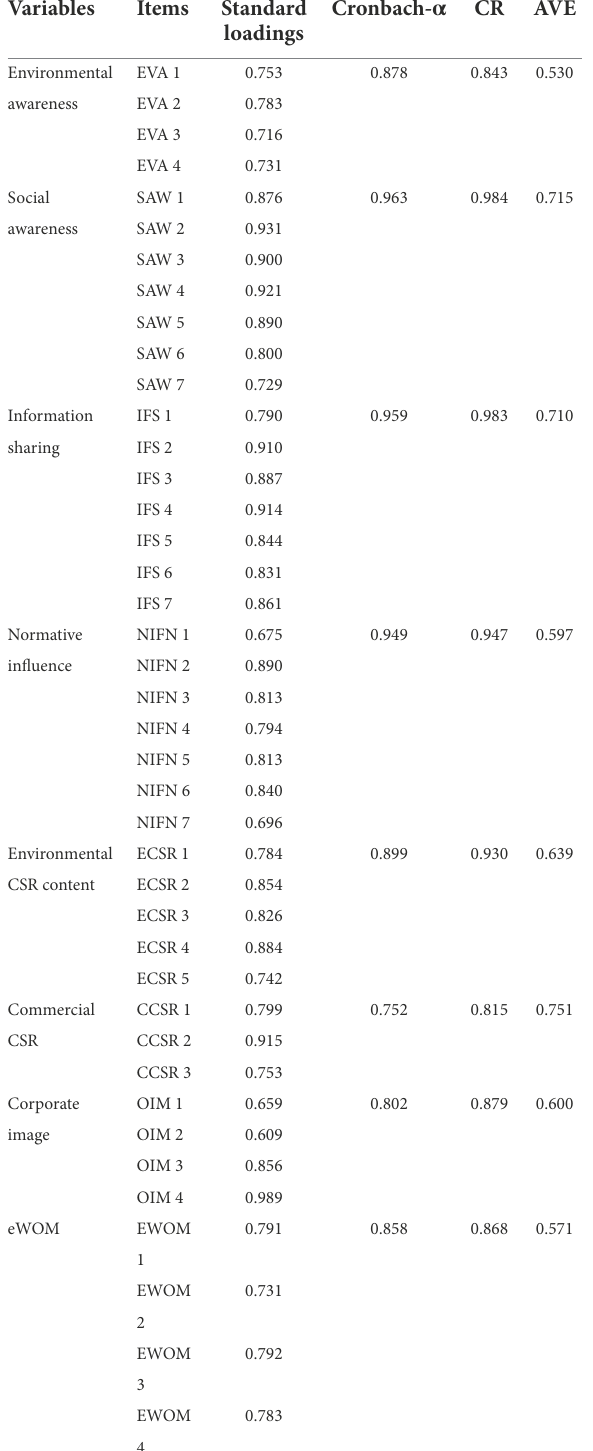
TABLE 4 Confirmatory factor analysis (measurement